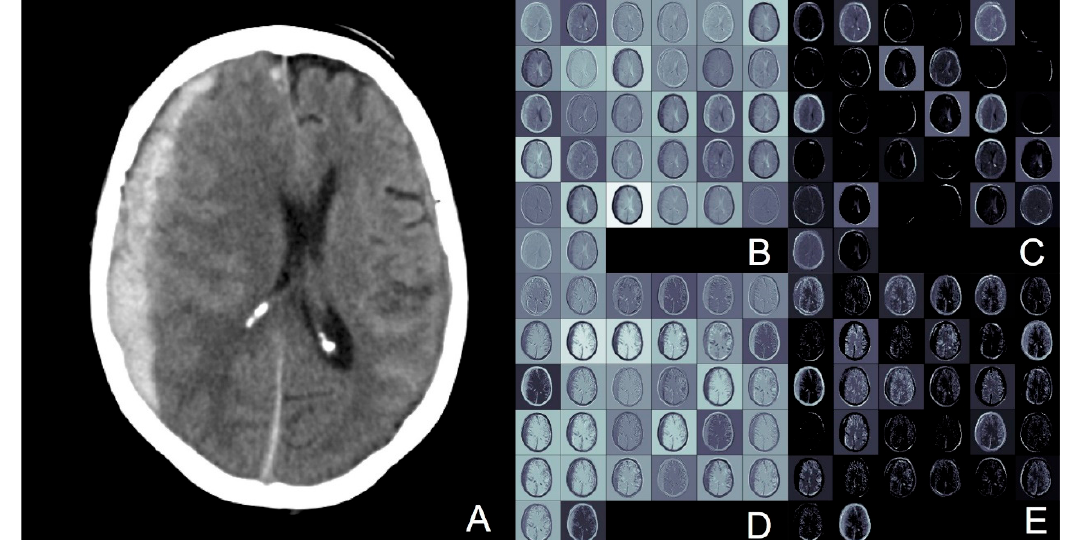
Figure 3. To demonstrate the effect of thresholding, a single slice of an ASDH CT Brain scan is shown, with the corresponding activations of convolution and pooling layers. A , original image. B , 1st convolution layer. C , 1st pooling layer. D , 1st convolution layer with thresholding applied. E , 1st pooling layer with thresholding applied. D and E appear sharper than B and C, demonstrating how thresholding can accentuate abnormal areas, and improve classifier performance.